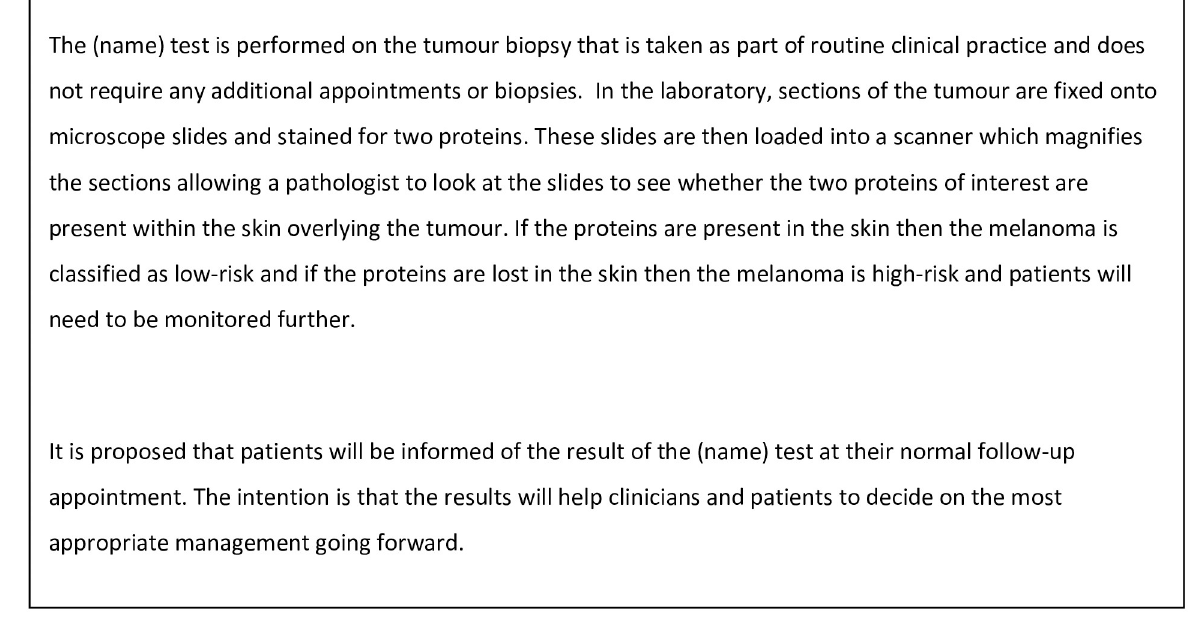
Fig 2. Information about the test provided to